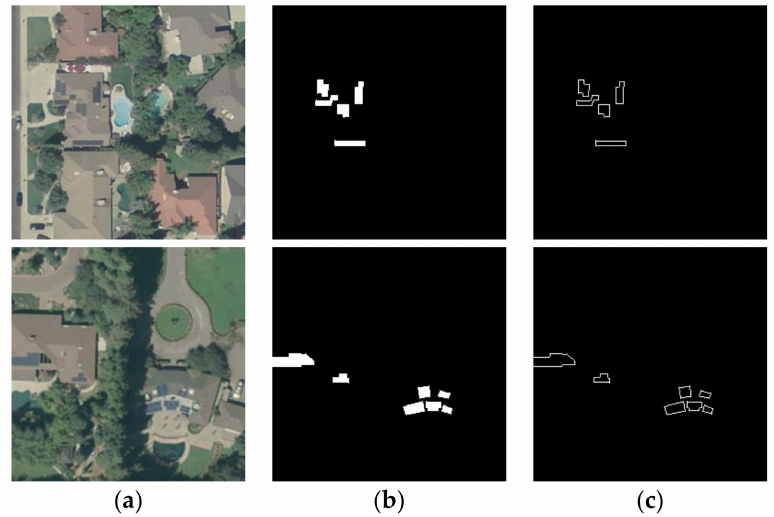
Figure 7. Samples from the Duke California Solar Array data set: ( a ) Image; ( b ) segmentation label; ( c ) edge label.